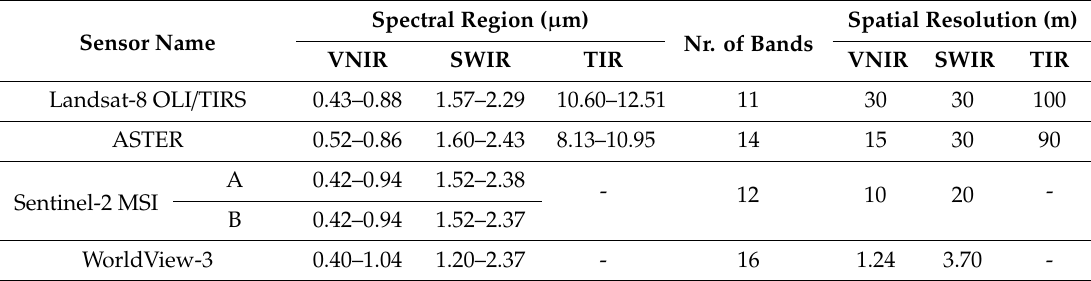
Table 2. Characteristics of sensors with potential for remote sensing of Li deposits